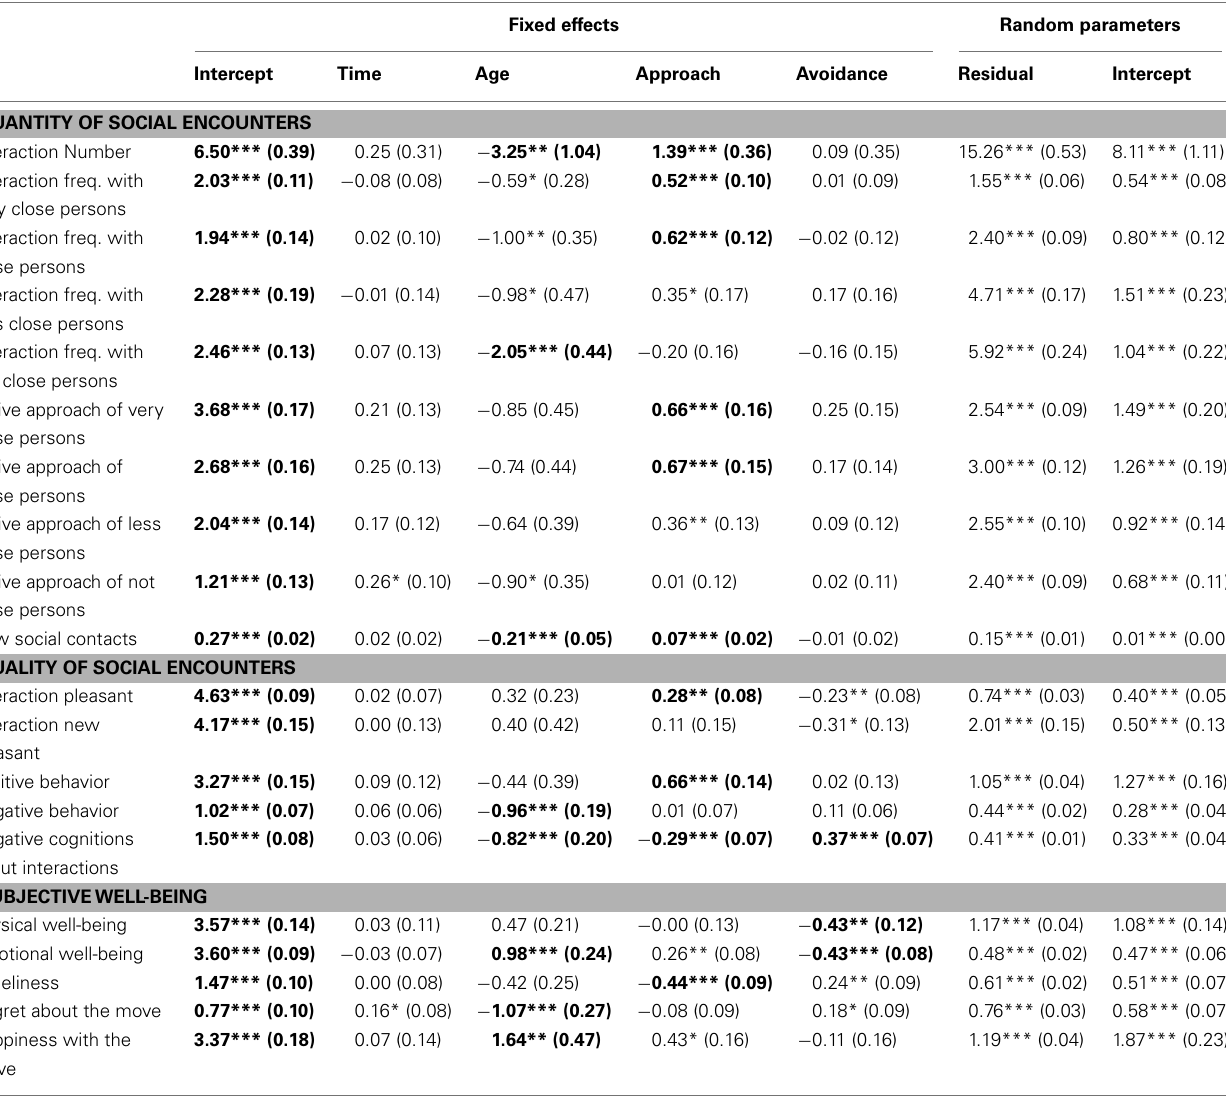
Table 3 | Estimates of fixed effects and random parameters for models of the predictors of daily social behavior and